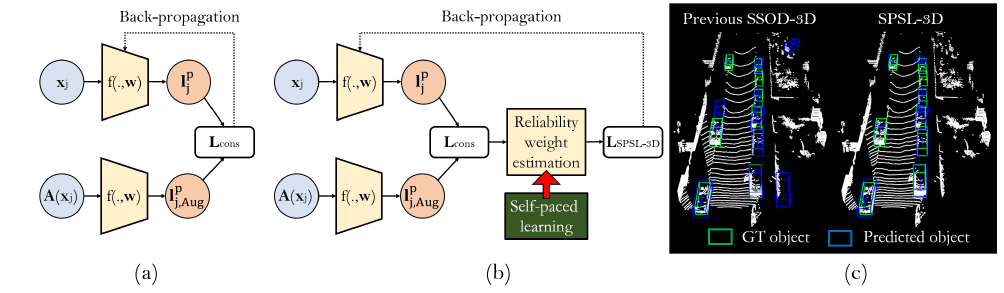
, adjusting the relia- j